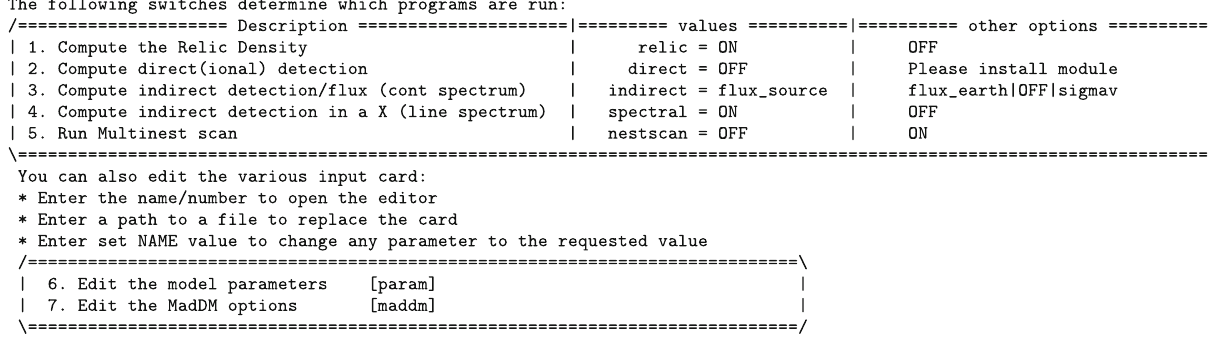
Fig. 7 Example of the launch interface after performing the launch command in MadDM for both tree level and loop-induced computa- tions. The relic density, standard indirect detection and indirect detec-